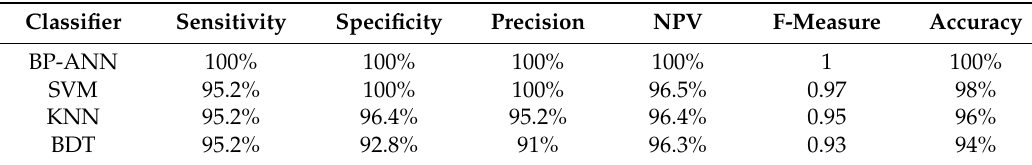
used as the input used as the input features.